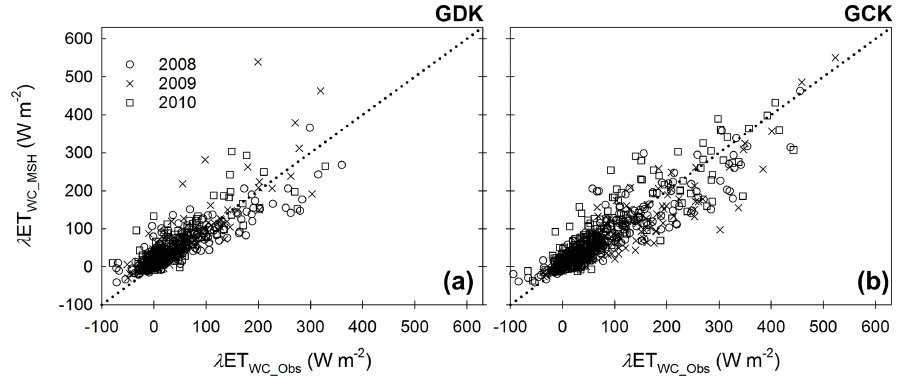
Figure 2. Comparison of the latent heat flux under (mostly) wet canopy conditions (i.e., W c /S > 2 / 3, where W c is the intercepted canopy water and S is the canopy storage capacity) at the GDK (a) and GCK (b) sites: λ ET WC_Obs indicates the observed latent heat flux under wet canopy conditions ( λ ET WC ) , while λ ET WC_MSH indicates the estimated λ ET WC using the MSH. The dotted line represents the 1 : 1